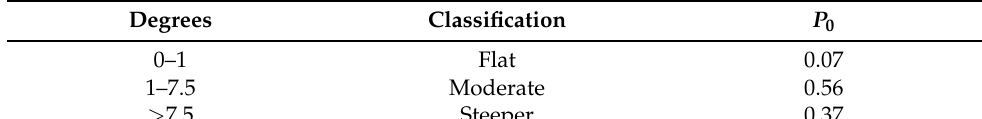
Table 7. Classification of slopes: Case #1.